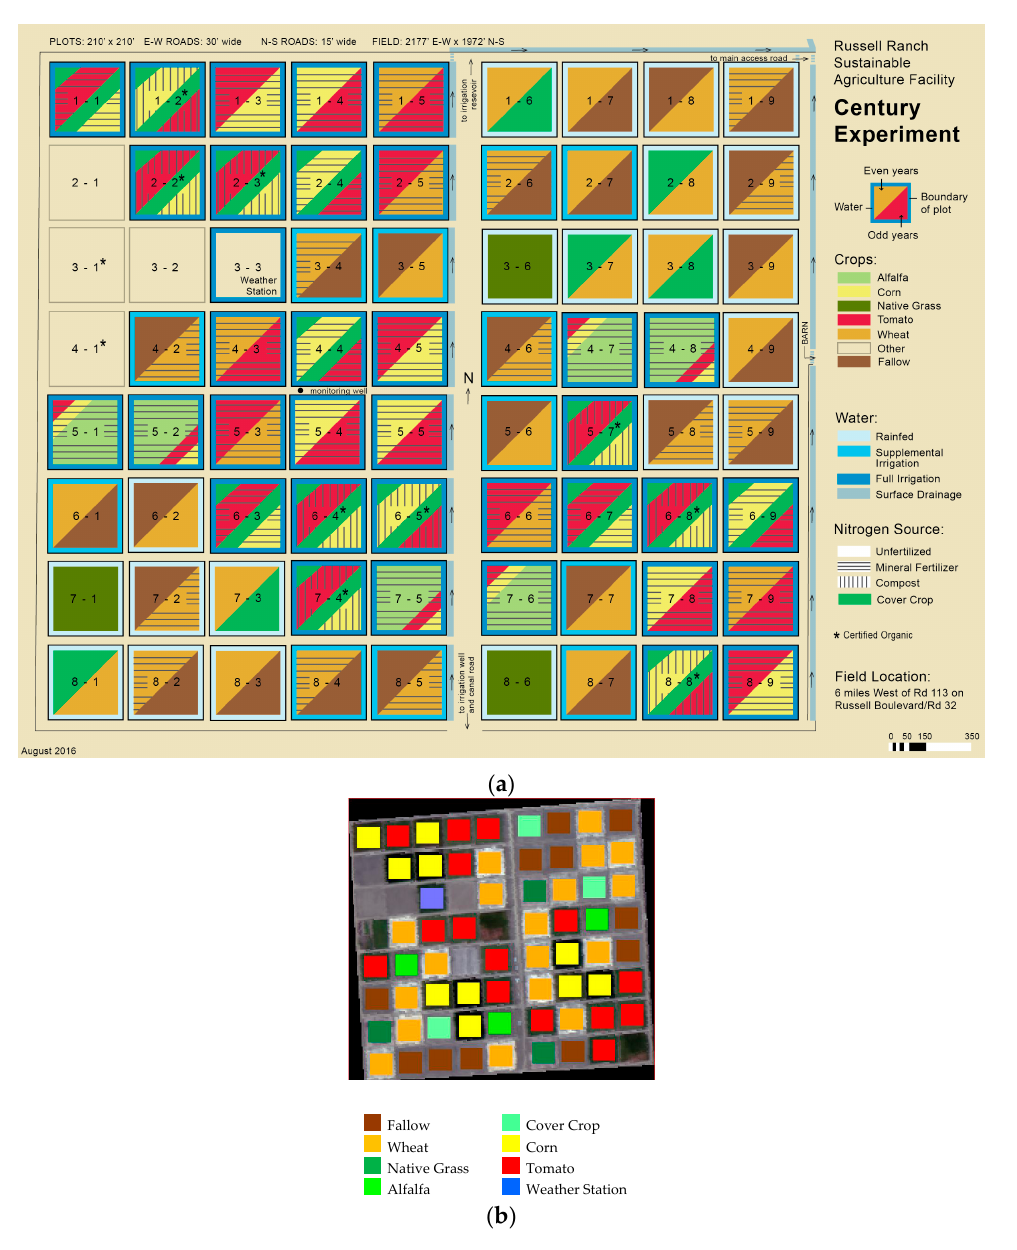
Figure 6. Long-Term Research in Agricultural Sustainability (LTRAS) dataset: ( a ) Planting schedule [38]; ( b ) Ground-truth map of the LTRAS farms.